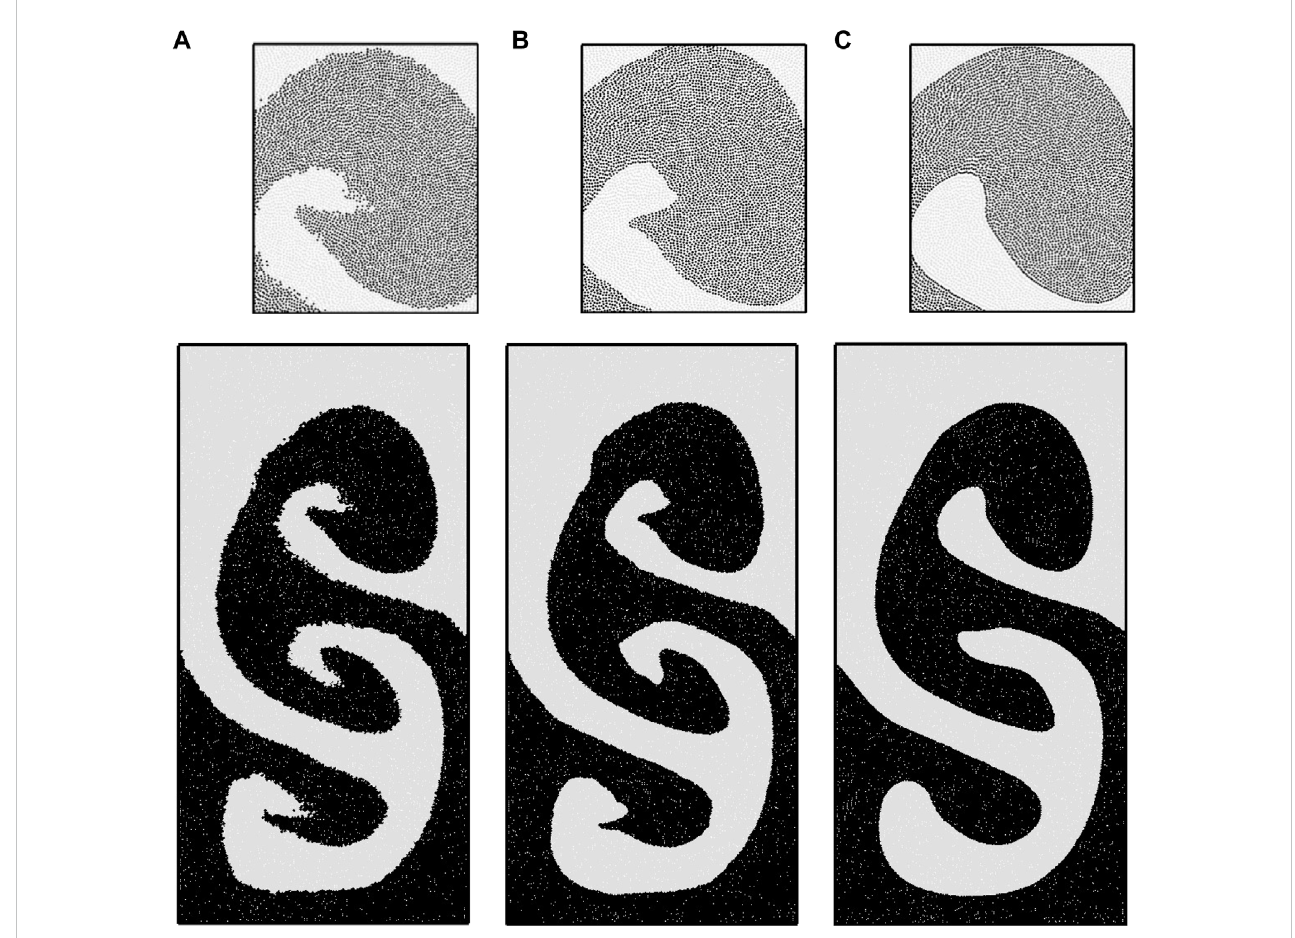
FIGURE 7 Snapshots ofR-Tinstabilityatt=5.0 sobtained byAMSPH-KGC, BMSPH-KGCwithrepulsiveforce ε =0.01,CMSPH-KGCwithrepulsiveforce ε